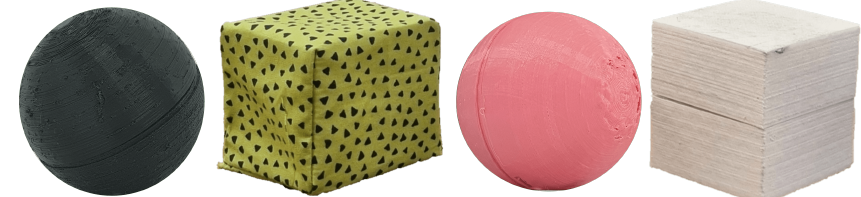
Figure 1. Set of instrumented toy